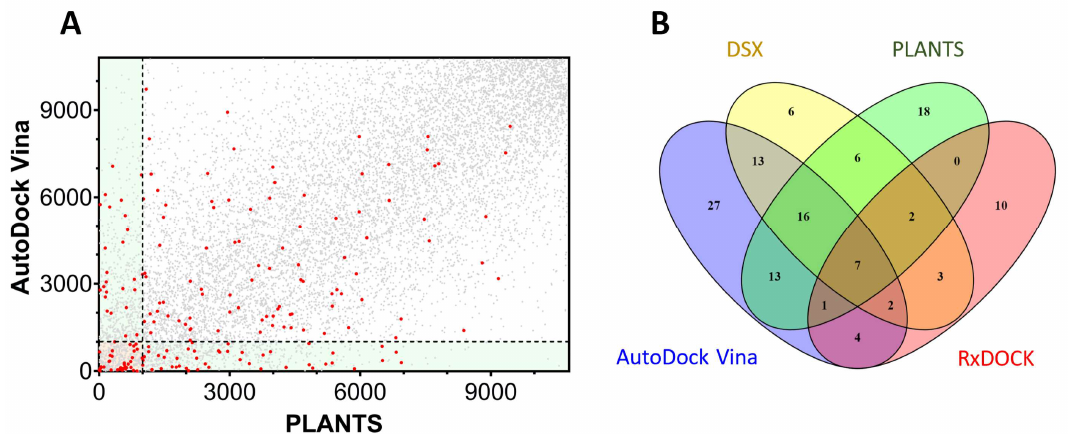
Figure 5. Dispersion of docking results in TRPV1. ( A ) Correlation between the results of AutoDock Vina and PLANTS. The docking results of AutoDock Vina were ranked and plotted against the ranking of the same molecules in PLANTS. The red dots represent the inhibitors obtained from the ChEMBL database while the grey dots indicate the decoys obtained from DUD-E. ( B ) A Venn diagram representing the intersections between four different docking programs (Vina, PLANTS, RxDock and DSX) used on TRPV1. The numbers indicate the amount of shared compounds detected by the different docking methods. The overlapping degree shown was calculated using the top 1000 molecules of the rankings.